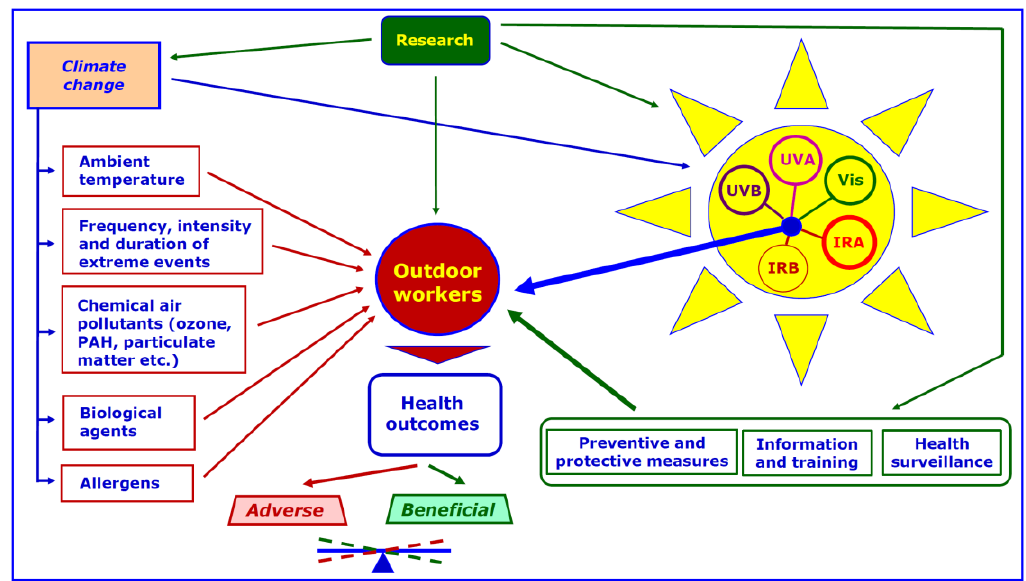
Figure 4. The balance between potential adverse and beneficial health outcomes for outdoor workers exposed to SR (Solar Radiation) depends on the whole SS (Solar Spectrum) and, in addition to the implementation of preventive and protective measures, is a ff ected by a variety of environmental and occupational co-exposures which, in turn, may be modulated by CC (Climate Change). An extensive research is needed to address properly these